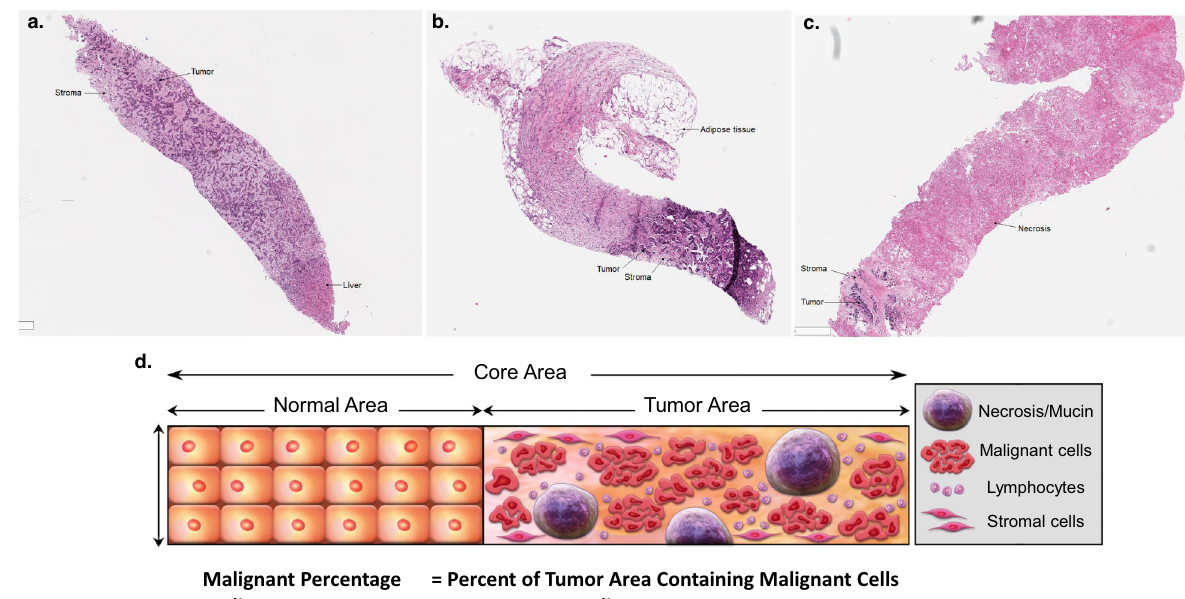
Fig. 4 Biopsy core. a A photomicrograph of a representative core biopsy containing 70% malignant cells. b A photomicrograph of a representative core biopsy containing 30% malignant cells. c A photomicrograph of a representative core biopsy containing 5% malignant cells. d The illustration demonstrates the various cellular elements that can be included in a biopsy core